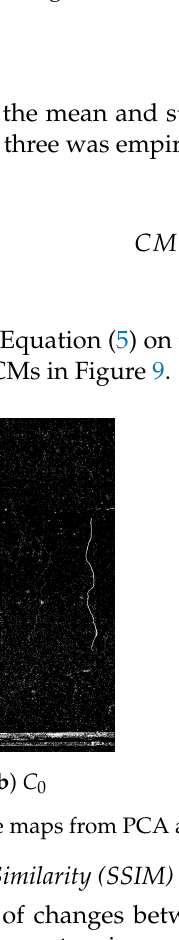
mined via SPC using: